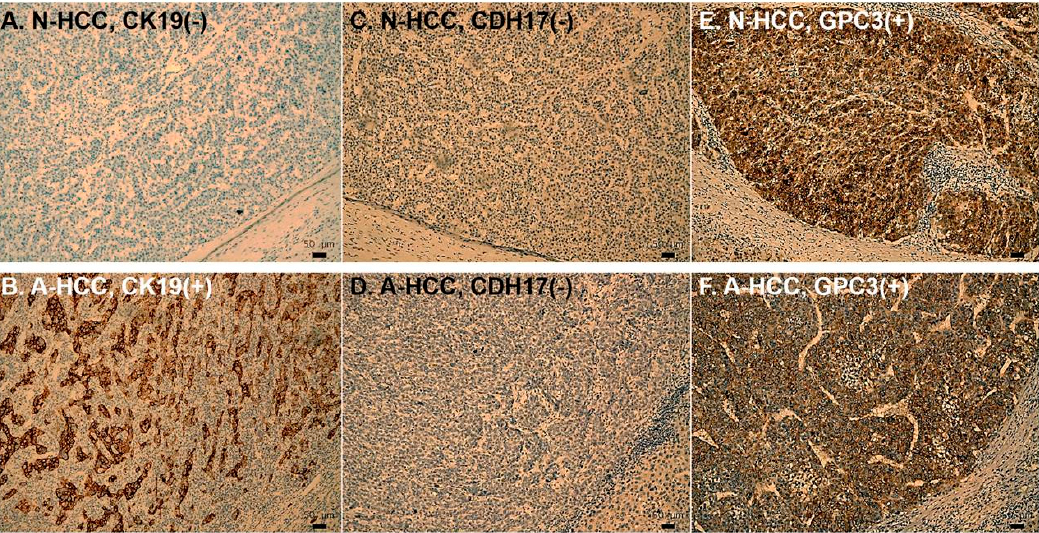
Figure 4. Immunohistochemical (IHC) microphotograph of primary HCC. The upper row ( A, C, E ) is IHC of N-HCC, while the lower row ( B, D, F ) is that of A-HCC. Most N-HCC and A-HCC ( E and F ) would express GPC3, while the expressions CDH17 were both low in N-HCC and A-HCC ( C and D ). CK19 was sparsely seen in N-HCC. About one-fourth of A-HCC tumors had CK19 expression ( B ); normal α -fetoprotein HCC; A-HCC, abnormal α -fetoprotein HCC; GPC3, glypican 3; CDH17,